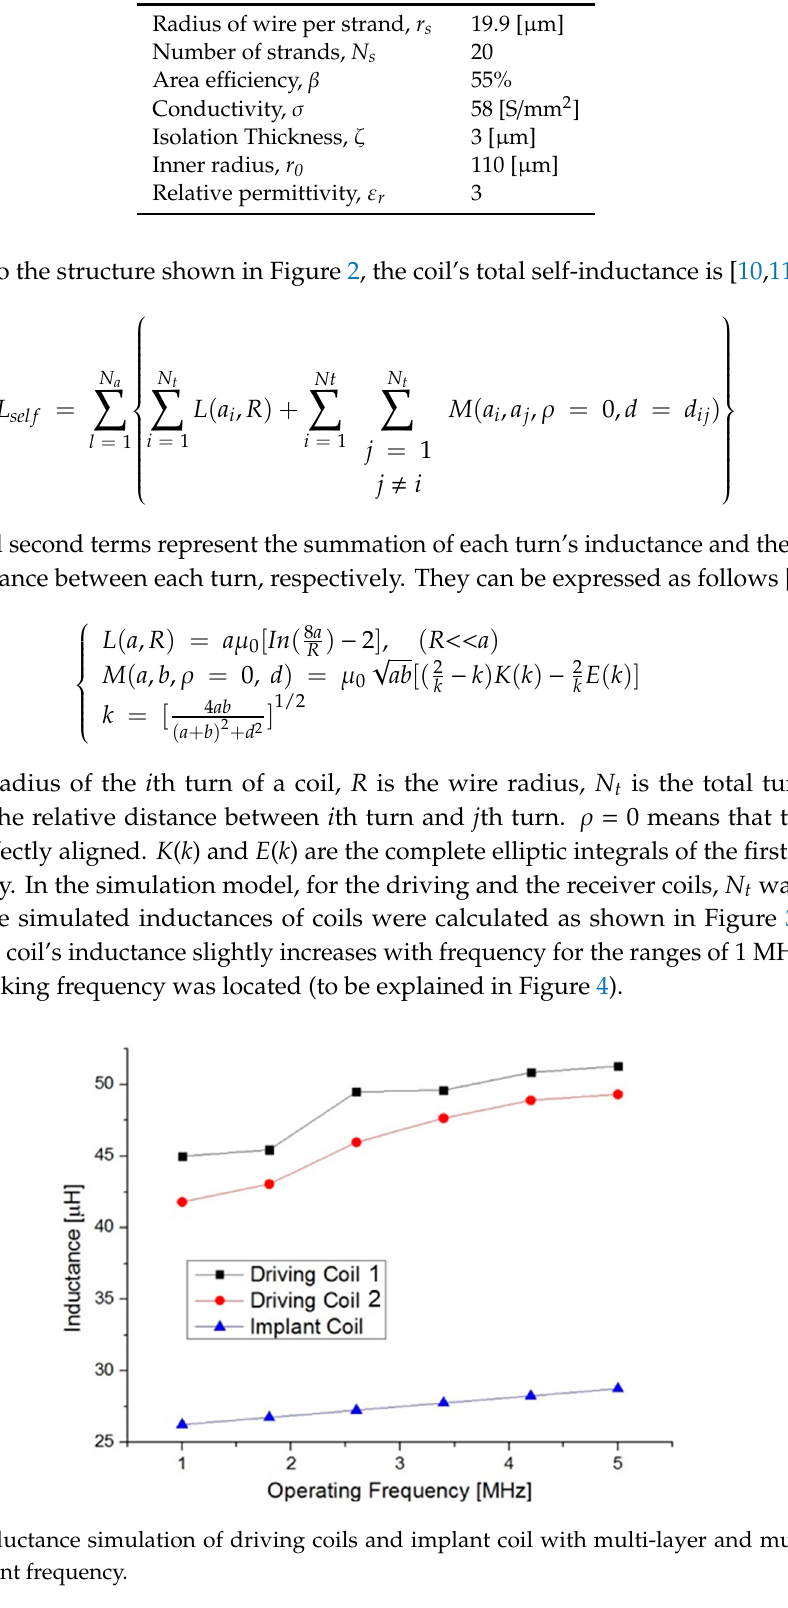
Figure 4. Q -factors’ curves versus operating frequency. In our work, the wire was tightly wound into multi-turn multi-layer, so the parasitic capacitance should be taken into account. In our coil design, the parasitic capacitance can be simplified to: